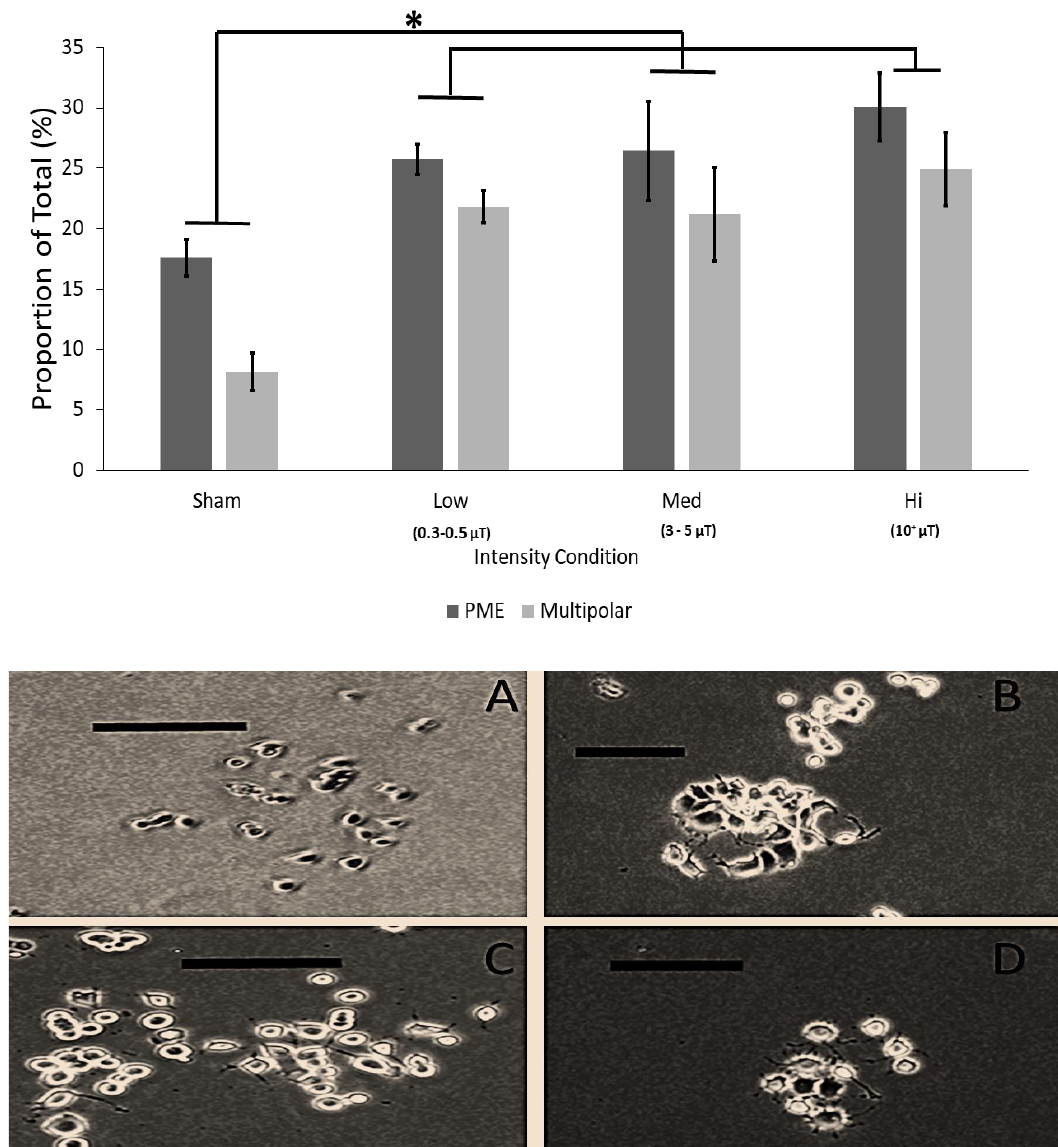
Figure 4. The graph (upper panel) shows the differences in the proportion of PME-bearing (dark bar) and multipolar extensions (light bar) of PC12 cells treated with the combination of 0.5 µM of forskolin and exposed to 1-h Burst-firing EMF of different intensities. Error bars represent SEM. Sham conditions were replicated 6 times and all other conditions were replicated in triplicate. For each replication, 2 plates were exposed in parallel and 4 sample photos were taken from each plate for cell counting. * indicates significant differences between groups ( p < 0.05). The photo shows representative